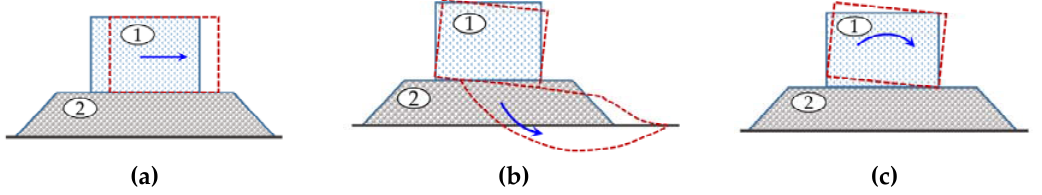
Figure 1. Overall failure mode of breakwaters (BRWs) studied: (a) Sliding, (b) Insufficient foundation bearing capacity, (c) Overturning.